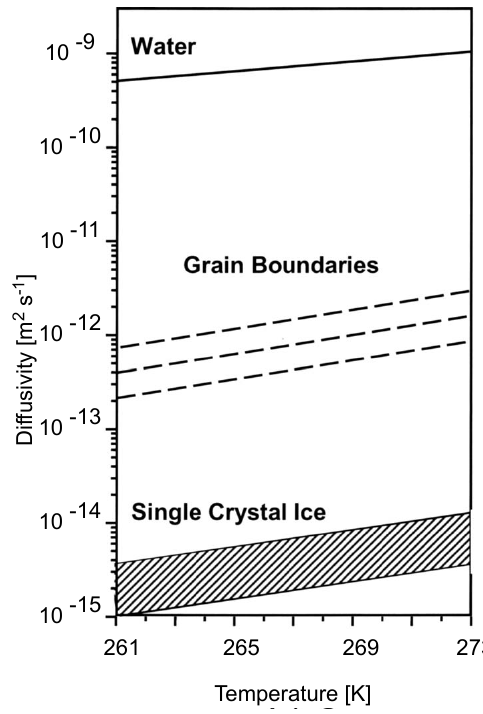
Fig. 12. Diffusivities of water molecules in ice and supercooled water. Adapted with permission from Lu et al. (2009). Copyright (2009) AIP Publishing